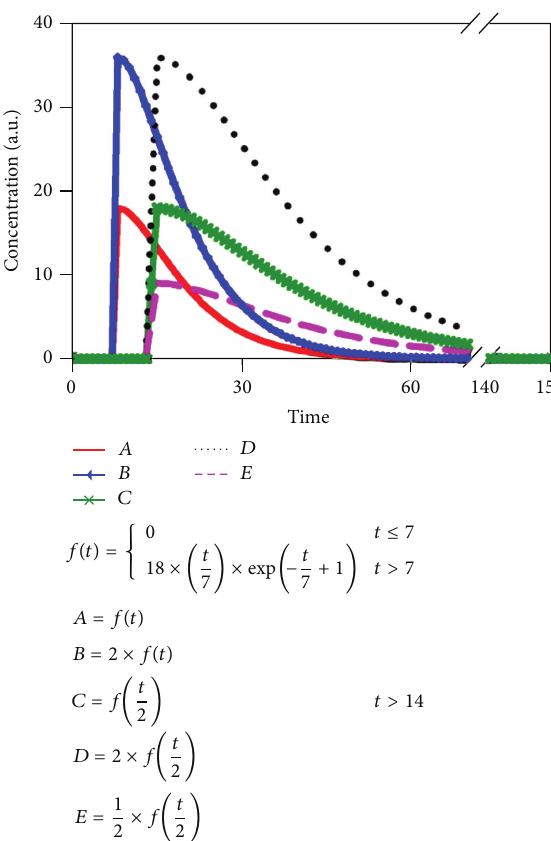
Figure 5: Various AIFs ( 𝐴 – 𝐸 ) are employed to test the decon- volution calculation for flow in dilution theory. “ 𝐴 ” (red line) is the ideal AIF defined in the paper [38] and the ideal flow is 80 mL/100g ⋅ min. The thresholding value is the cut-off value in adaptive SVD calculation [33]. 𝐵 – 𝐸 curves are the nonideal AIFs simulated. Table 3: Estimated flow obtained from calculation of Figure 5. Estimated flow Area under curve Thresholding (%) 76.40 262.43 13.64 524.86 27.27 523.18